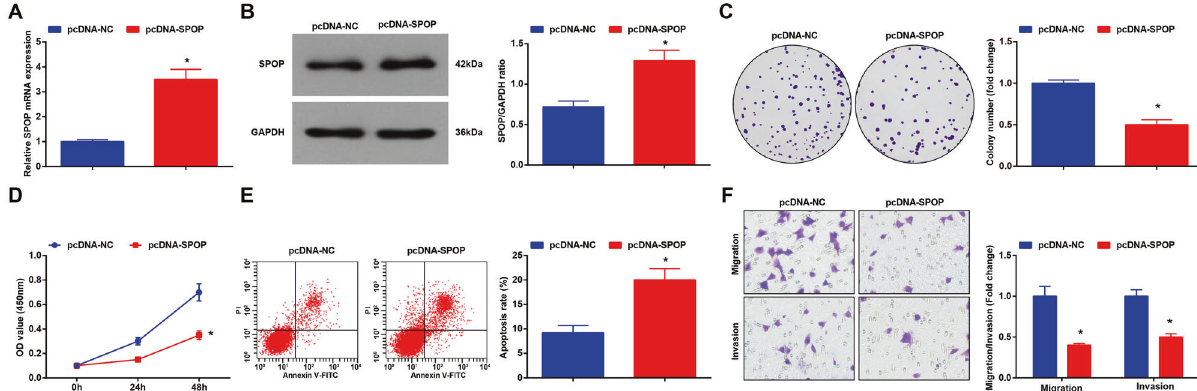
Fig. 7 SPOP overexpression inhibits the biological functions of HCT116 cells. A SPOP expression in HCT116 cells detected using RT-qPCR after transfected with pcDNA-SPOP; B SPOP expression in HCT116 cells detected using western blot analysis after transfected with pcDNA- SPOP; C proliferation of HCT116 cells detected using colony formation assay after transfected with pcDNA-SPOP; D proliferation of HCT116 cells detected using CCK-8 assay after transfected with pcDNA-SPOP; E apoptosis of HCT116 cells detected using fl ow cytometry after transfected with pcDNA-SPOP; F migration and invasion of HCT116 cells detected using Transwell assay after transfected with pcDNA-SPOP. Cell experiments were repeated three times; * P < 0.05 vs the pcDNA-NC group; the measurement data were expressed as mean ± standard deviation.